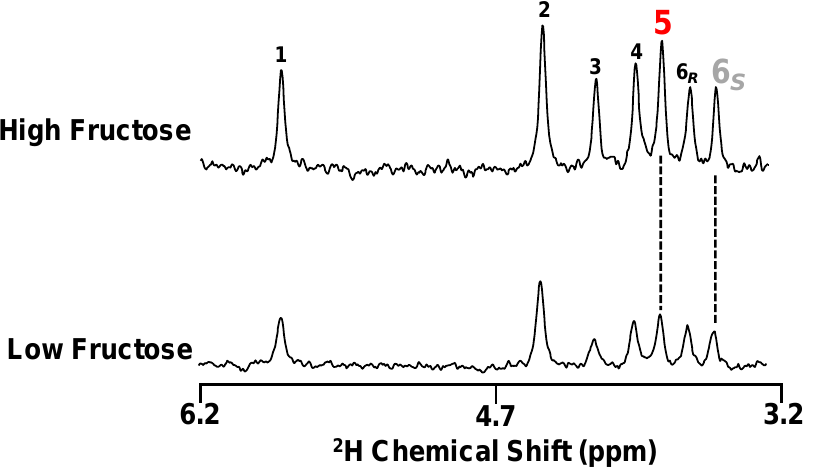
Figure 4. Representative 2 H NMR spectra of the MAG derivatives of plasma glucose of healthy subjects after ingestion of a meal with 50 g sugar consisting of 55/45 fructose/glucose (High Fructose) or 5/95% fructose/glucose (Low Fructose). The vertical height of each spectrum is scaled to the 2 H-enrichment of position 5. The numbers above each signal represent the 2 H position in the plasma glucose, with positions 5 and 6S highlighted in red and gray, respectively.